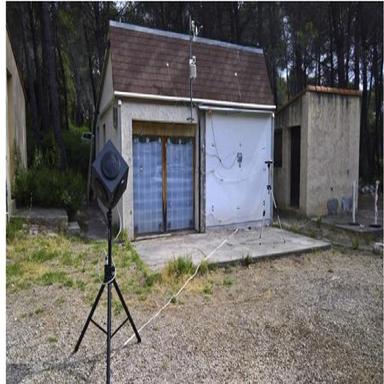
Outside position of the loudspeaker.